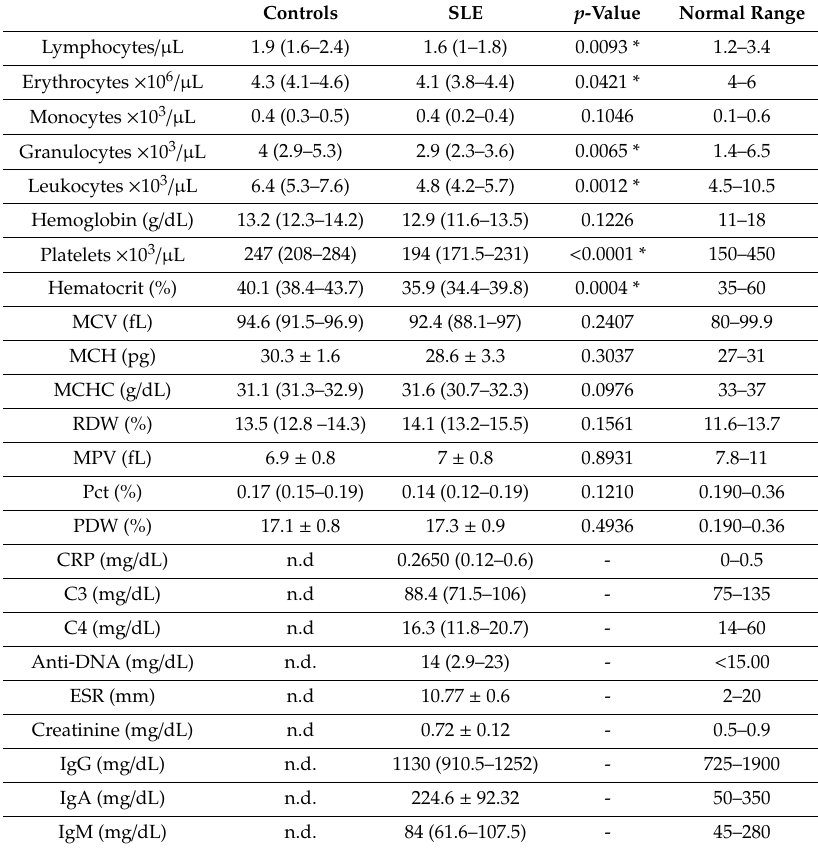
Table 2. Biochemical parameters in the healthy controls and patients with SLE.